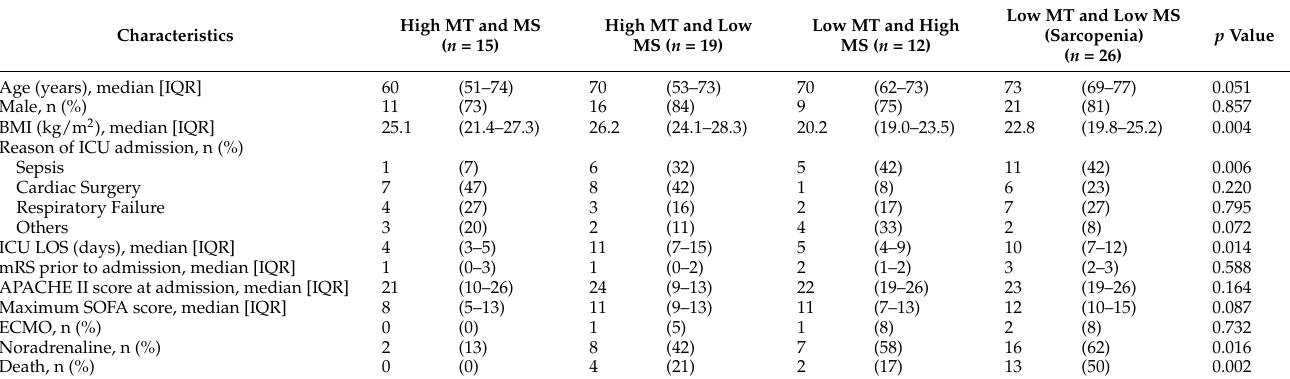
Figure 2. Receiver operating characteristics curves of muscle thickness only and muscle thickness plus muscle strength for 1-year mortality. AUC: area under the receiver operating characteristics curve. Table 2. Comparison of patient characteristics between the four groups.